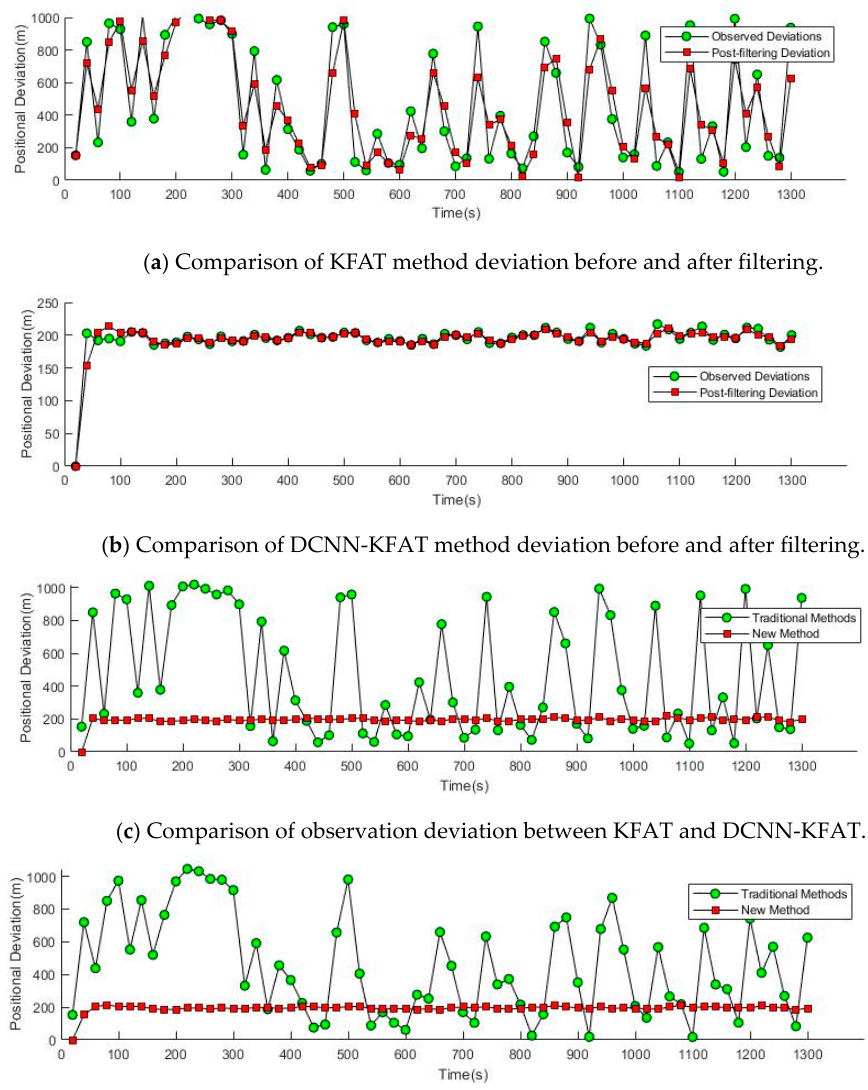
Figure 19. The deviations of KFAT and DCNN-KFAT before and after filtering are listed separately, and the deviation of DCNN-KFAT is significantly smaller than that of KFAT, with an improvement of 500~700 m.